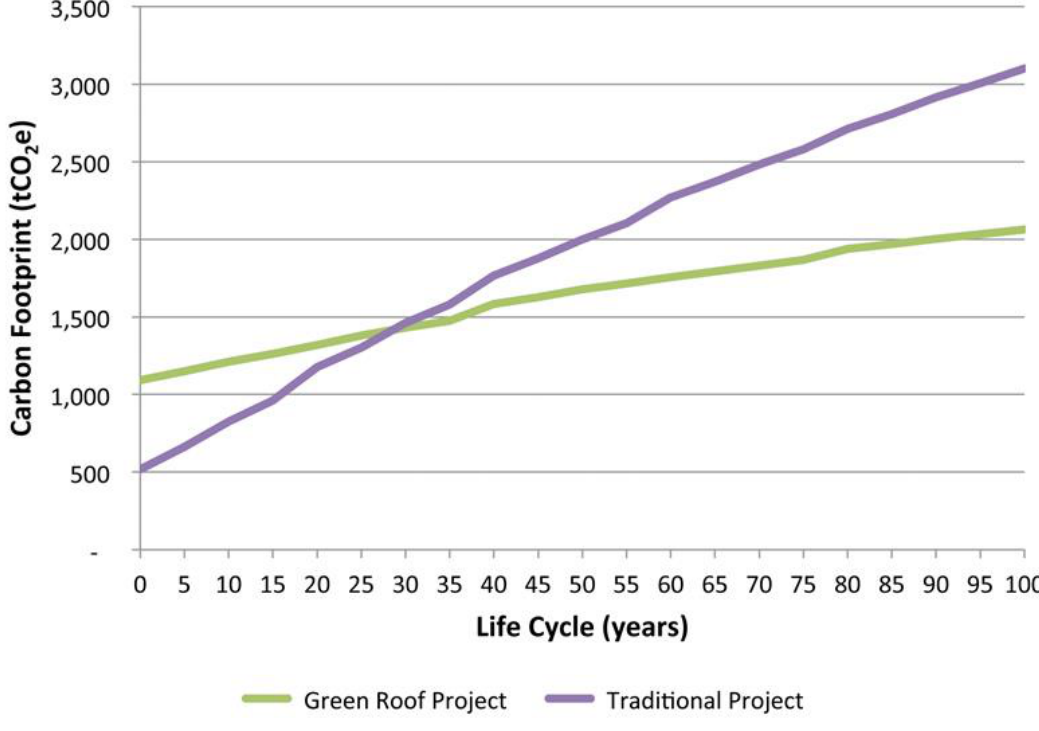
Figure 8: Environmental performance